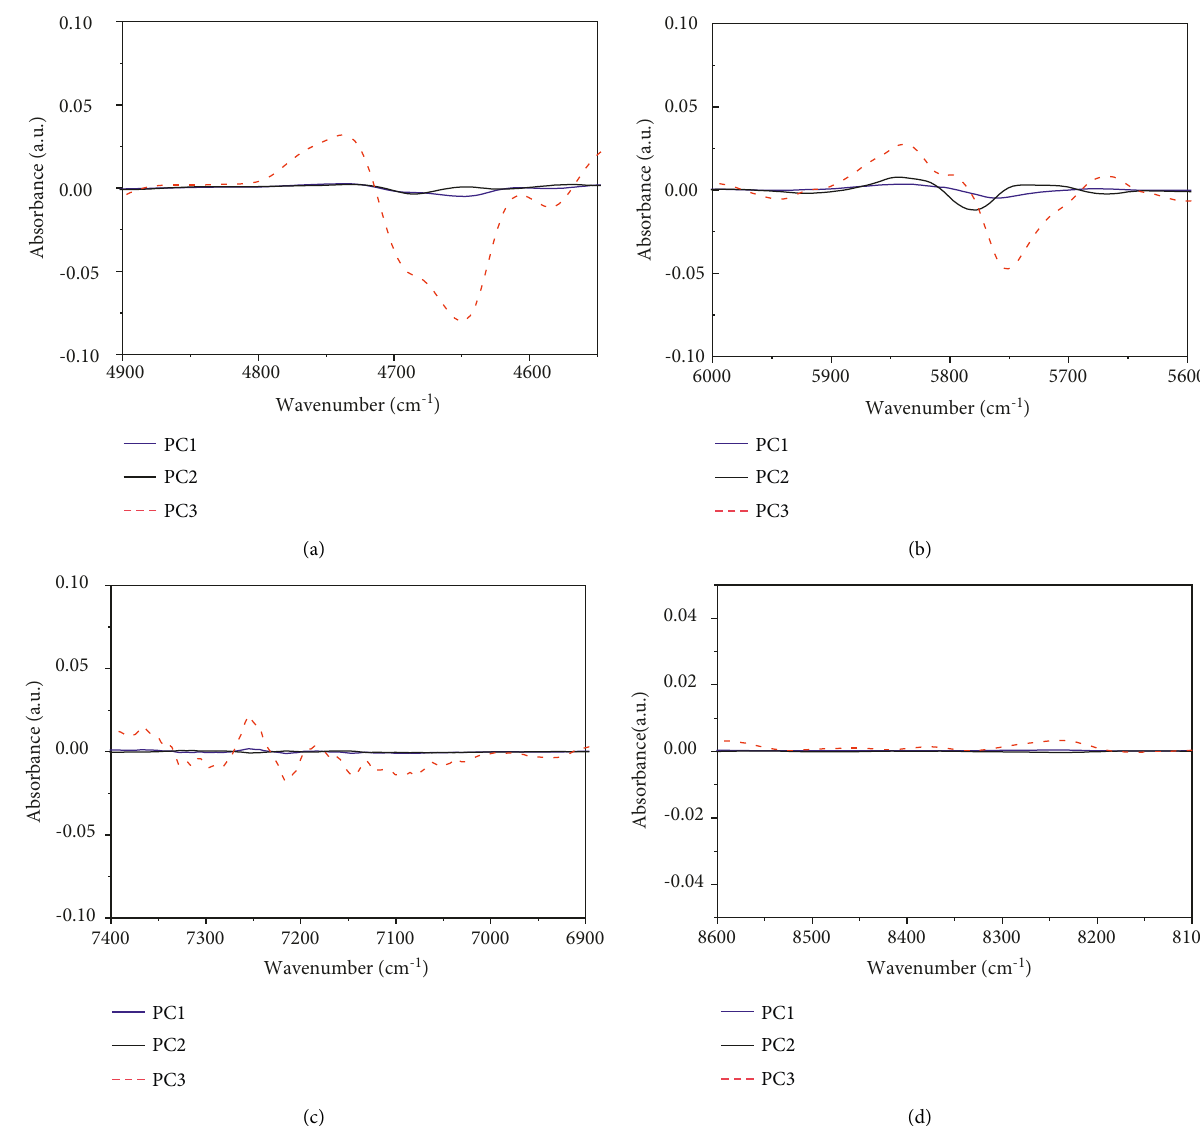
Figure 8: PCA loadings diagrams of the sample. PCA loadings in the ranges of 4770–4520, 6000–5670, 7400–6900, and 8400–8100cm − 1 are shown in (a), (b), (c), and (d), respectively.